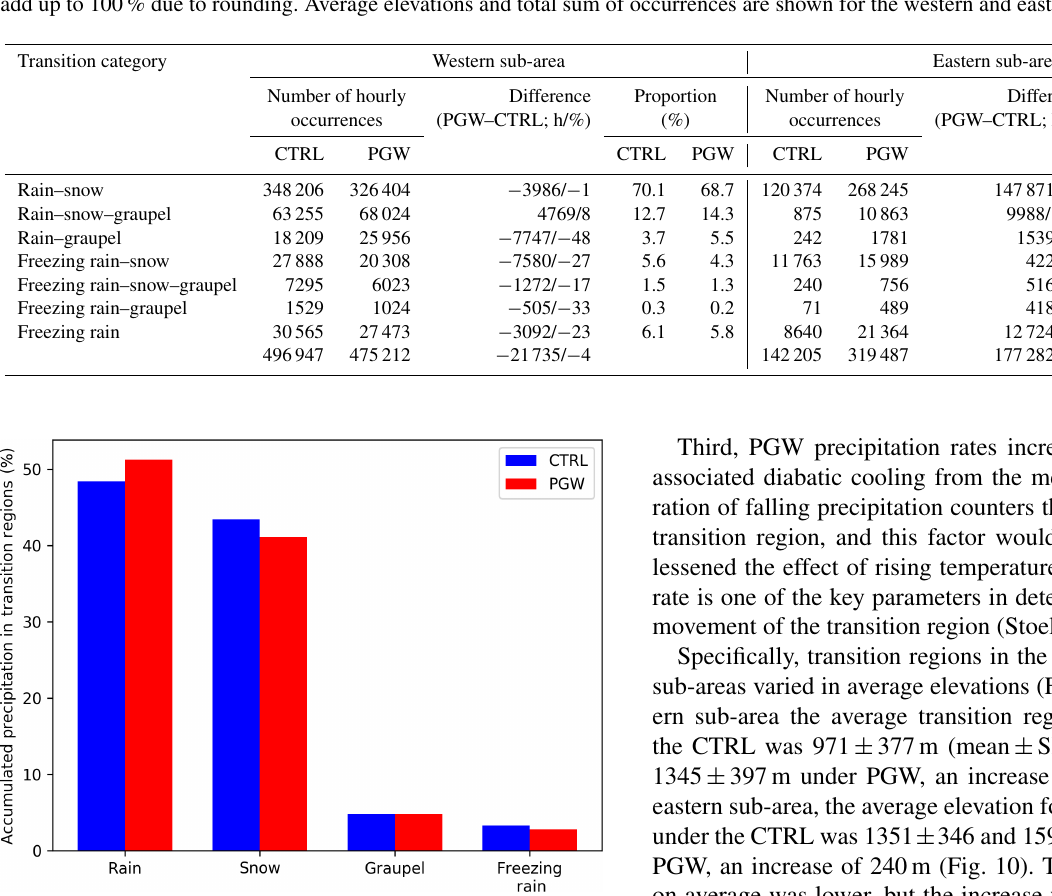
Figure 8. Distribution of accumulated rain, snow, graupel and freez- ing rain within transition regions under the CTRL (blue) and PGW (red) simulations over the January–April 2010